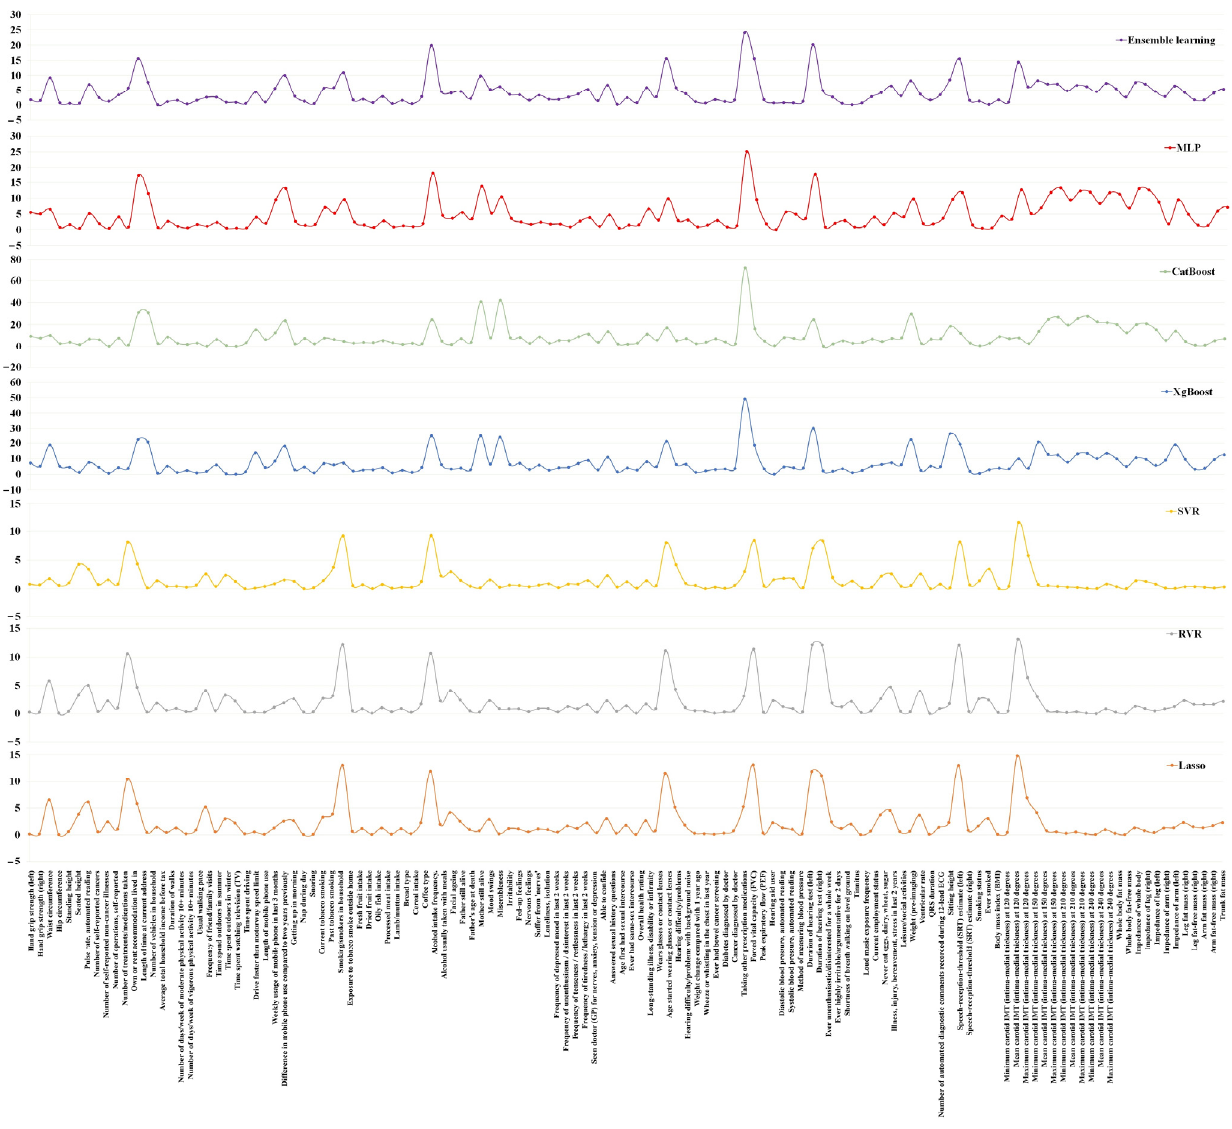
Figure 5. A Manha tt an plot of -log 10 of FDR corrected p values ( y axis) by non-IDPs ( x axis) . Figure 5. A Manhattan plot of -log 10 of FDR corrected p values ( y axis) by non-IDPs ( x axis).